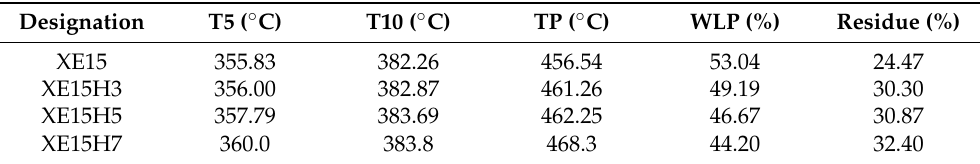
Figure 11. ( a ) Thermogravimetric analysis (TGA) and ( b ) DTG thermograms of various XNBR/Epoxy/XHNTs at heating temperature of 5 °C/min. Table 6. Thermal decomposition characteristics of XNBR/Epoxy/XHNT nanocomposites calculated from TGA and DTG thermograms at heating temperature of 5 °C/min.